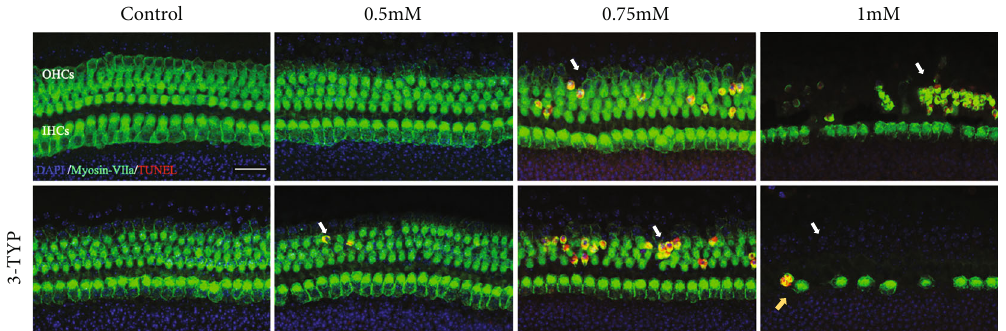
Figure 6: H O induce occurrence of hair cell apoptosis, and this is intensi fi ed by 3-TYP. Representative images of TUNEL staining (red) 2 2 and hair cells (green) in 0, 0.5, 0.75, and 1 mM groups pretreated with or without 3-TYP. The white arrows indicate TUNEL-positive cells in OHC areas. Yellow arrows indicate TUNEL-positive cells in IHC areas. Scale bar = 25 μ